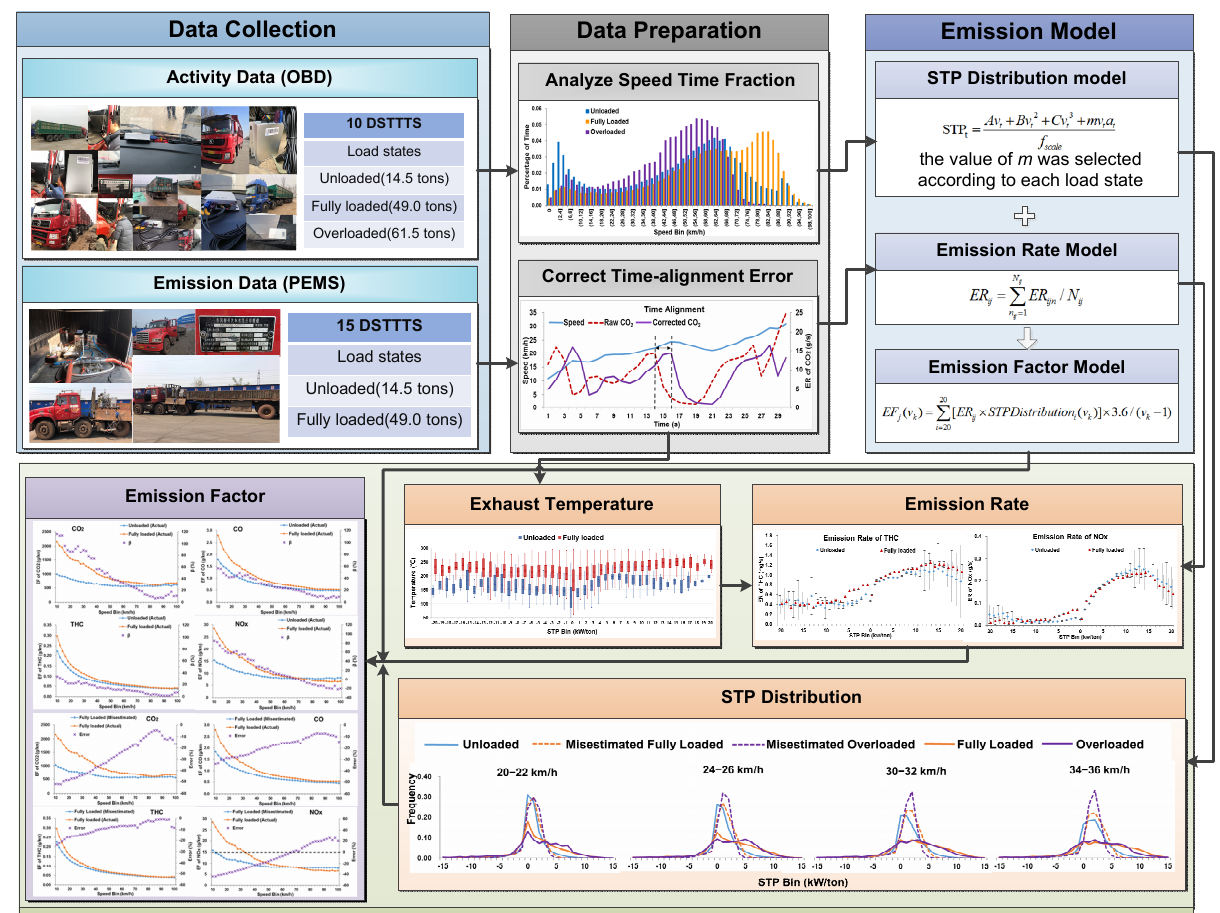
Figure 1. Framework of this study.